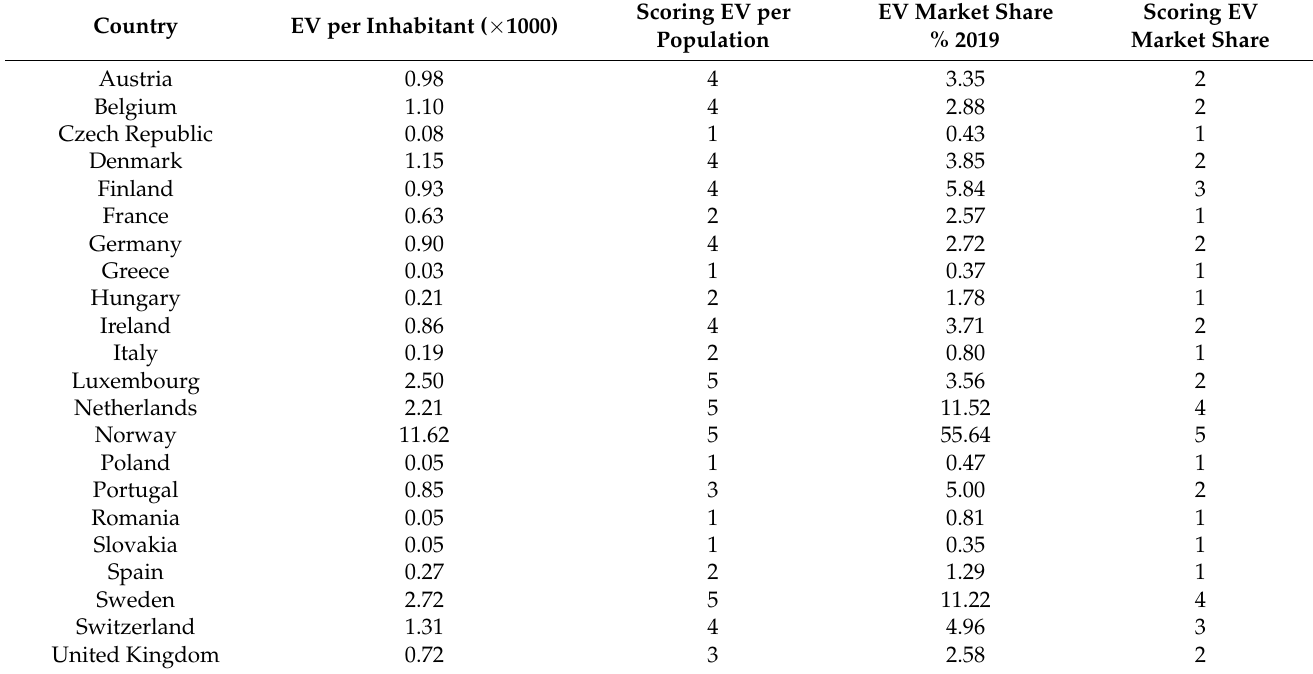
Table 3. Charging infrastructure maturity in 2019 (Source: Leaseplan)